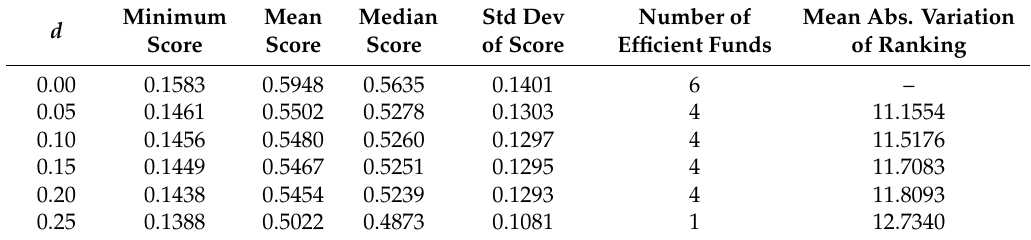
Table 5. Main results for the VW restrictions with constraints on all DMUs in the case of asymmetric bounds and T = 7. Summary statistics on the performance scores (minimum, mean and median values, standard deviation), number of efficient funds and mean absolute variation (divided by 2) of the ranking